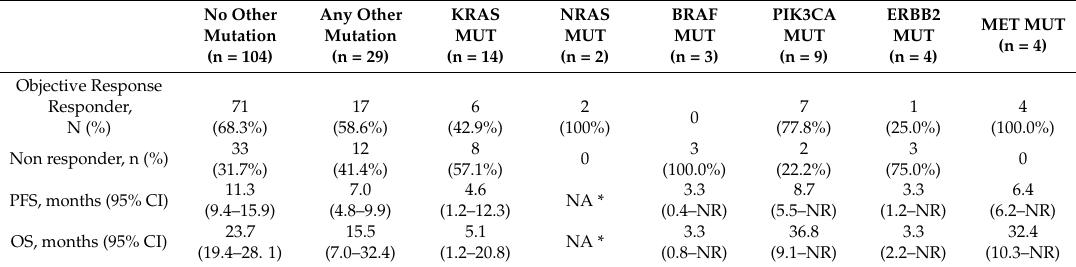
Table 3. Outcome of patients with and without other